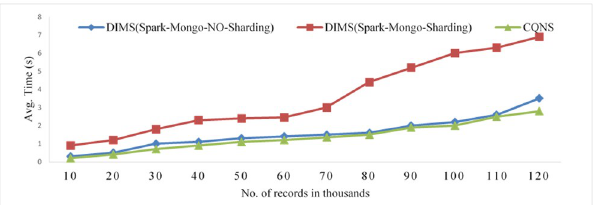
Fig 14. Comparison of the average time using mongo import and apache spark with Sharding and no-Sharding and CQNS.